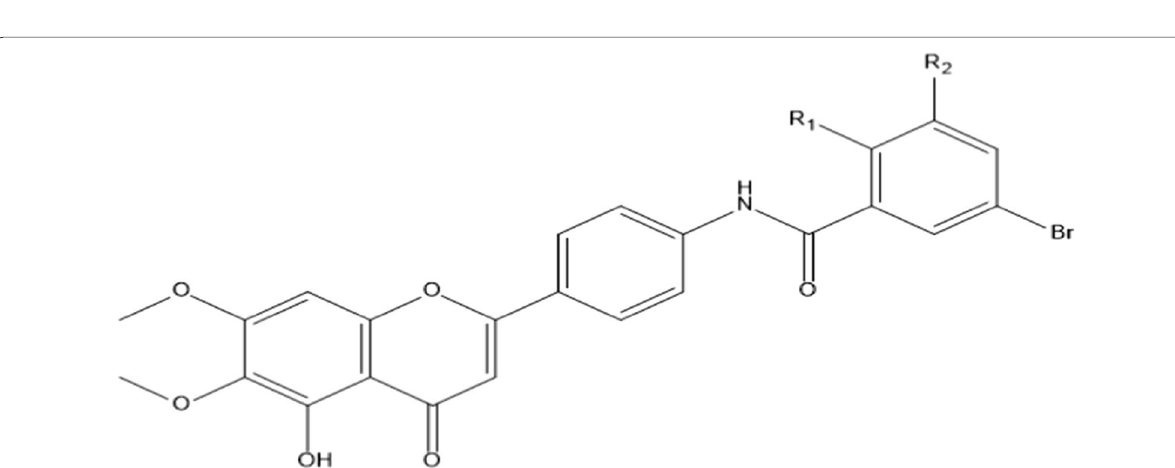
Fig. 2 Structural skeleton of compound 28 showing R 1 and R 2 positions as a point of